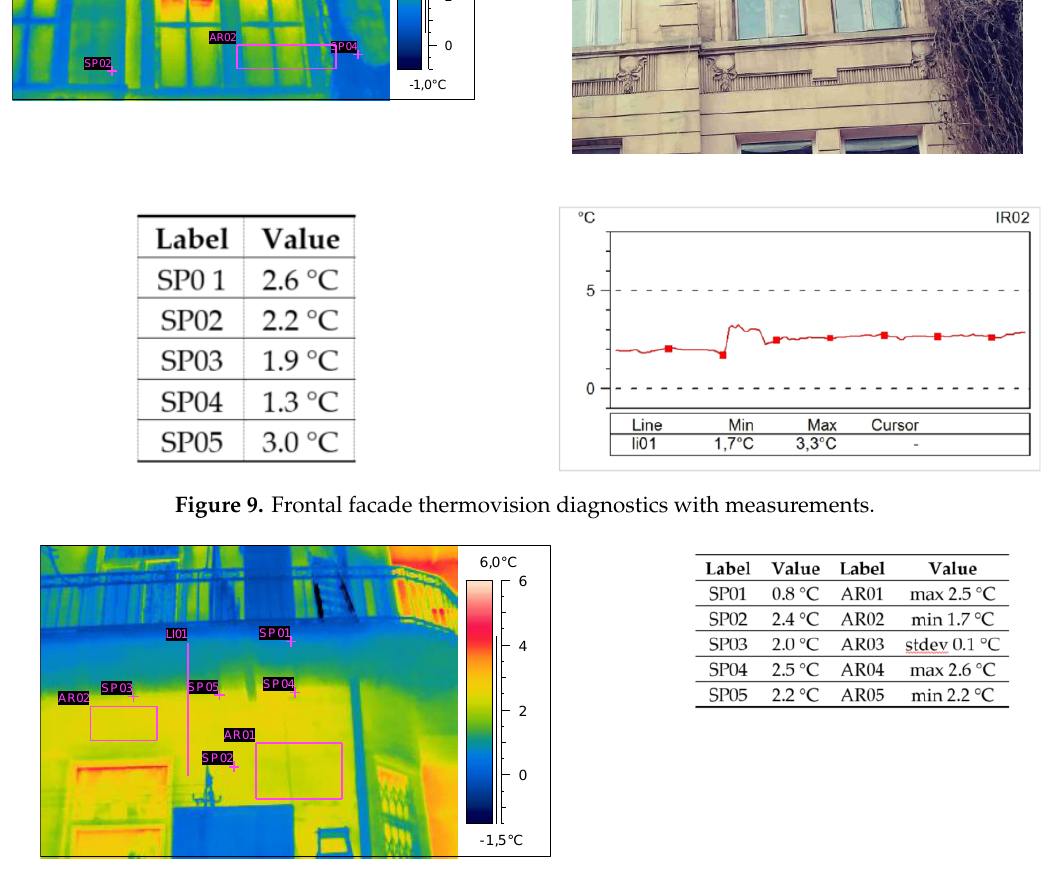
Figure 10. Sample thermogram with markings showing the areas under analysis and where temperature readings were taken, i.e., under steel beams. The thermograms were made at night, meaning that the walls were not affected by sunlight.